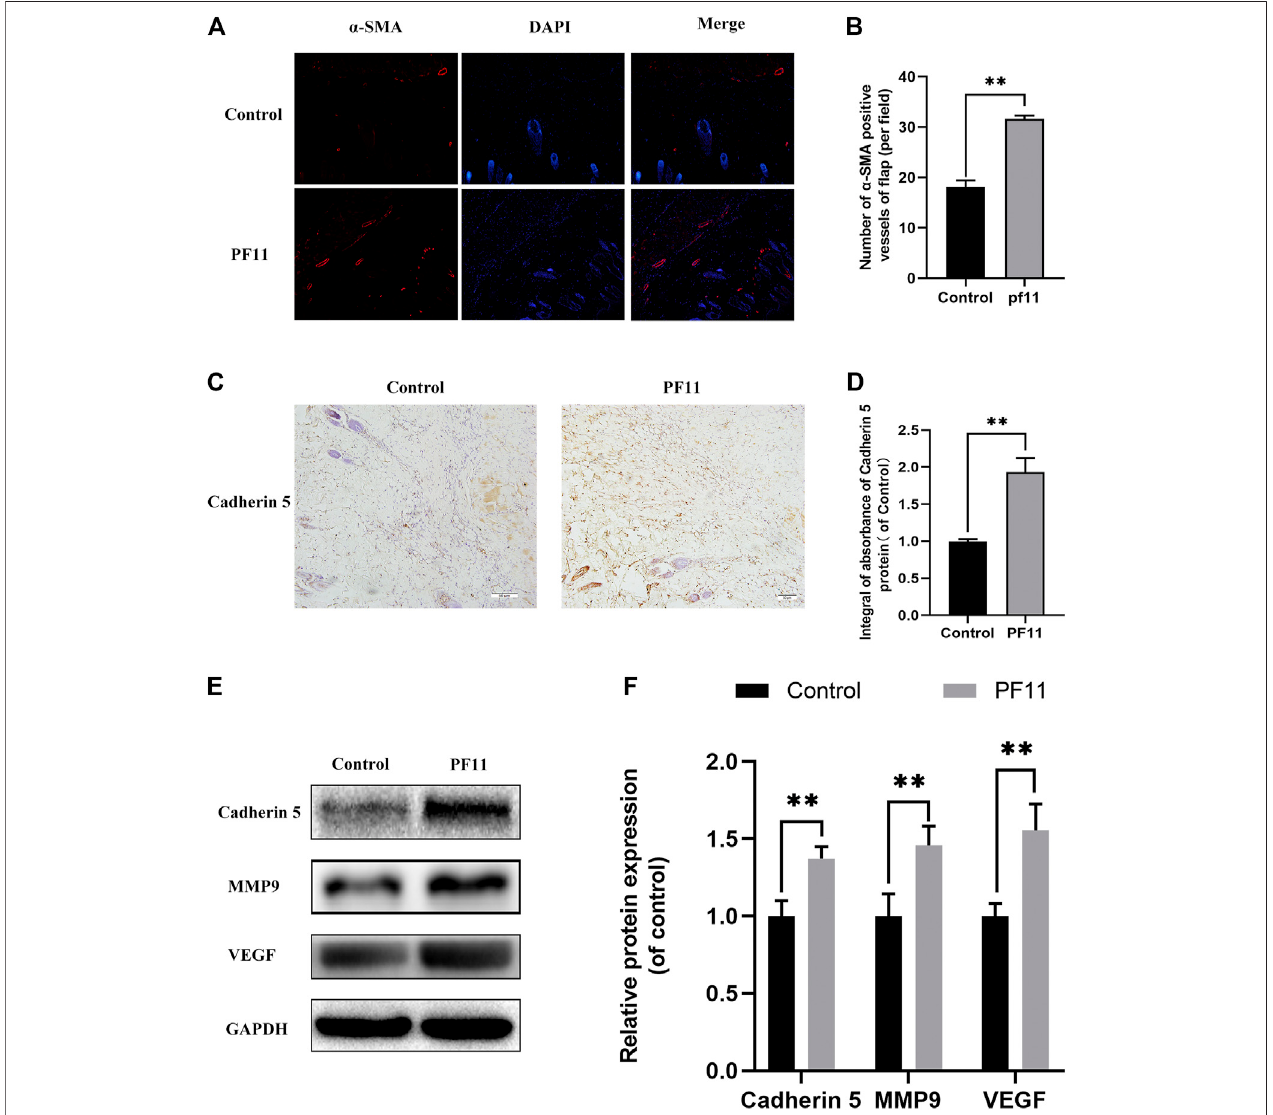
FIGURE2| PF11enhancesangiogenesisinrandomskin fl aps. (A) Immuno fl uorescencestainingfor α -SMAlabeledmicrovessels(scalebar:20 µm). (B) Histogram showing thepercentages ofa-SMA positivemicrovesselsin the control and PF11 groups. (C) IHC results showing the Cadherin 5expression inrandomskin fl aps(scan bar, 50 μ m). (D) A histogram exhibiting the integral absorbance of Cadherin 5. (E) Results of western blotting showing the expression of MMP9, VEGF, Cadherin 5, and GAPDH.Croppedblotsareshown. (F) HistogramshowingopticaldensityvaluesofMMP9,VEGF,andCadherin5inthecontrolandPF11groupinthe fl aps.Values are expressed as means ± SD, n (cid:2) 6 per Group. * p < 0.05 and ** p < 0.01, vs. control group.